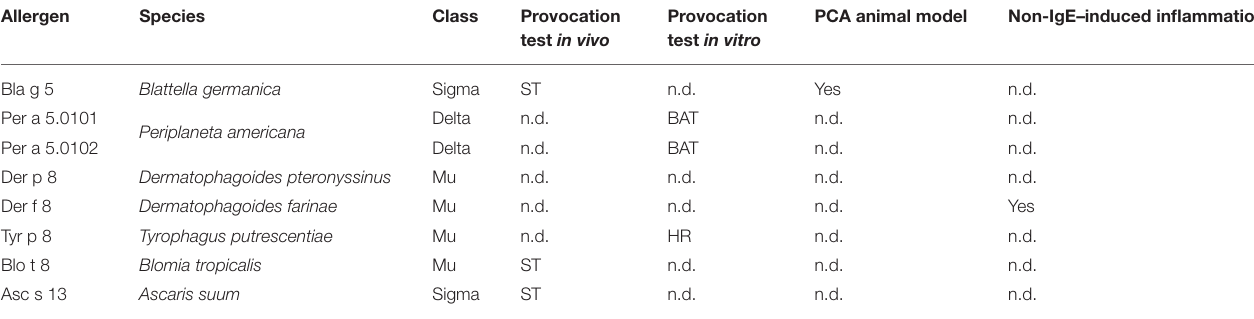
TABLE 1 | The allergenic activity of glutathione-S transferase (GST) from invertebrates officially named as allergens. Allergen Species Class Provocation Provocation PCA animal model Non-IgE–induced inflammation test in vivo test in vitro Bla g 5 Blattella germanica Sigma ST n.d. Yes Per a 5.0101 Periplaneta americana